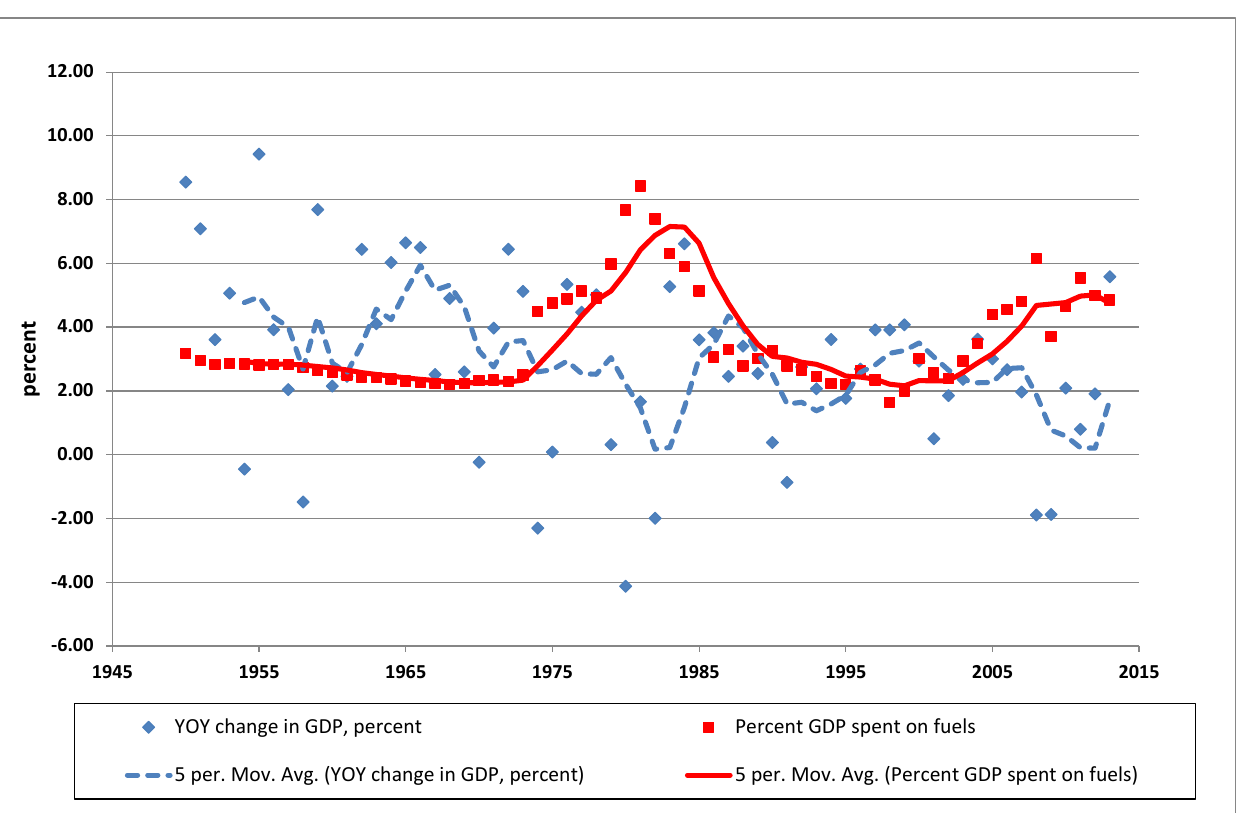
Figure 4. Year-over-year percent change in real GDP and percent GDP spent on fuel, 1950 through 2013, and five-period (per.) moving averages (each period is one